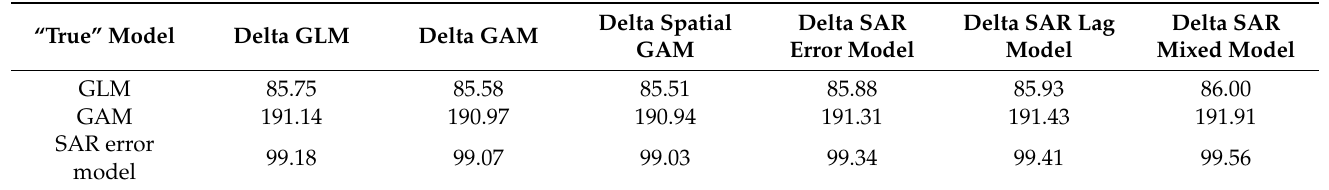
Table 4. Simulation error for six delta models fitted to NEAMAP weakfish survey data after 500 itera- tions. The “true” models are the models used for data